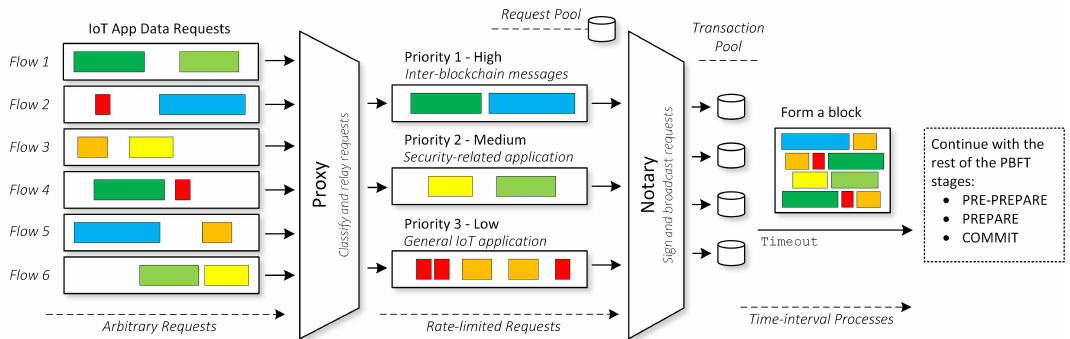
Figure 4. The request prioritization strategy in the Core Engine using Proxy nodes. First, the Proxy nodes classify IoT application requests based on their importance. Second, they retransmit the request to Notary nodes following a rate-limiter